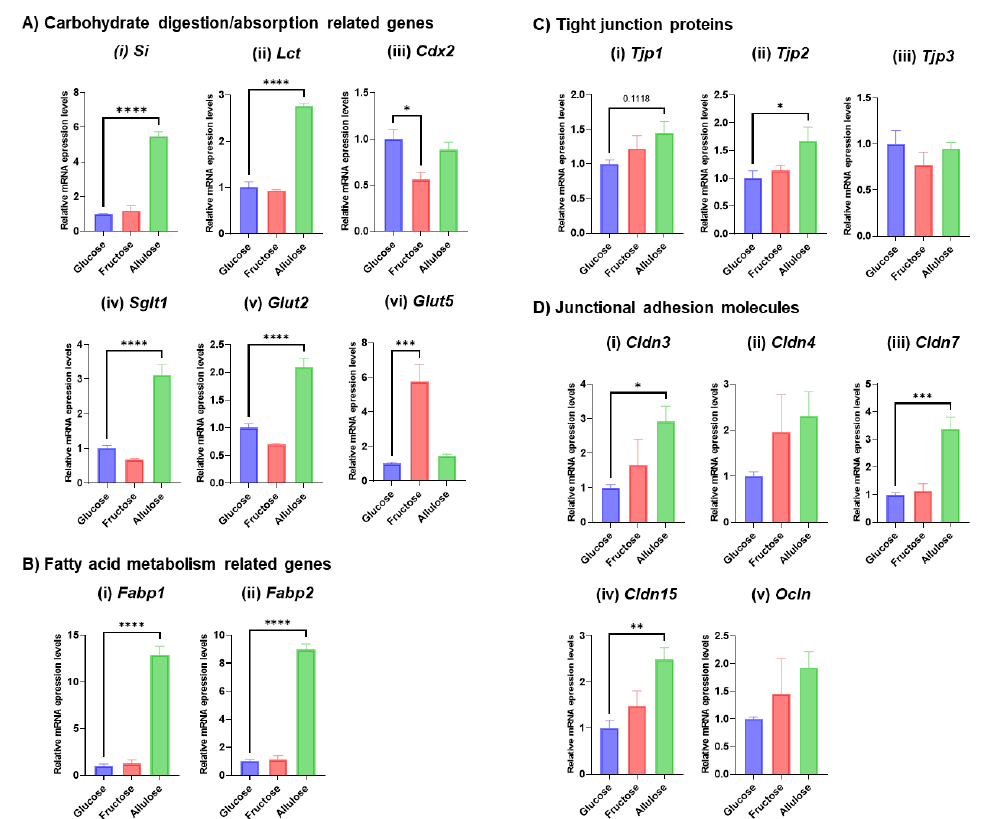
Figure 3. Gene expression levels of representative genes related to nutrient digestion and absorption, and intestinal barrier. ( A ) Results of qRT-PCR for carbohydrate digestion/absorption-related genes. ( i ) Si , ( ii ) Lct , ( iii ) Cdx2 , ( iv ) Sglt1 , ( v ) Glut2 and ( vi ) Glut5 . ( B ) Results of qRT-PCR for fatty acid metabolism-related genes. ( i ) Fabp1 and ( ii ) Fabp2 . ( C ) Results of qRT-PCR for tight junction proteins. ( i ) Tjp1 , ( ii ) Tjp2 and ( iii ) Tjp3 . ( D ) Results of qRT-PCR for junctional adhesion molecules. ( i ) Cldn3 , ( ii ) Cldn4 , ( iii ) Cldn7 , ( iv ) Cldn15 and ( v ) Ocln . Values indicate mean ± SEM ( n = 4). Asterisks indicate significant differences tested using the ANOVA-Dunnett’s multiple comparisons test (vs. glucose-perfused group, **** p < 0.0001, *** p < 0.001, ** p < 0.01, * p <